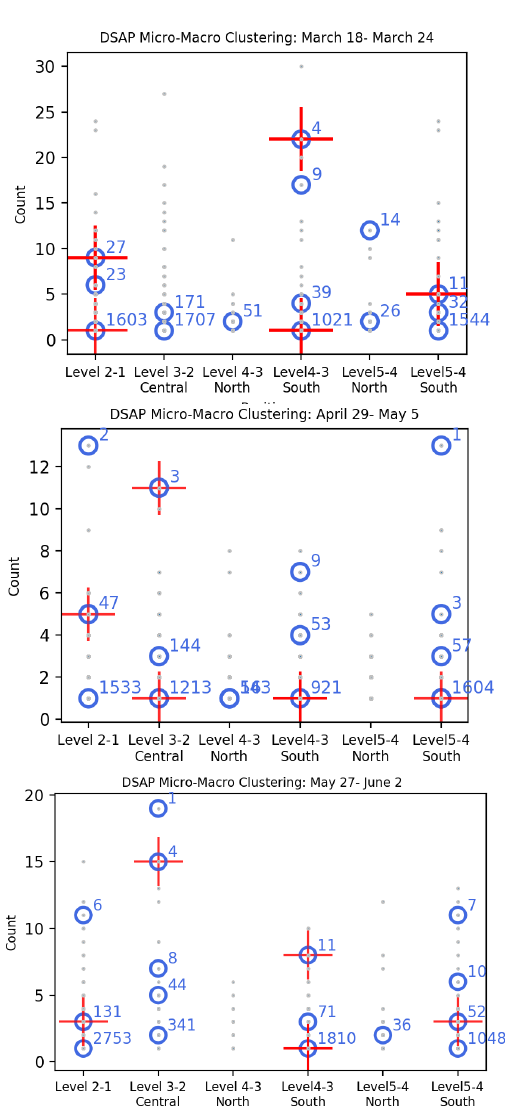
Figure 5: Clustering results for the first week before, during, and after the intervention